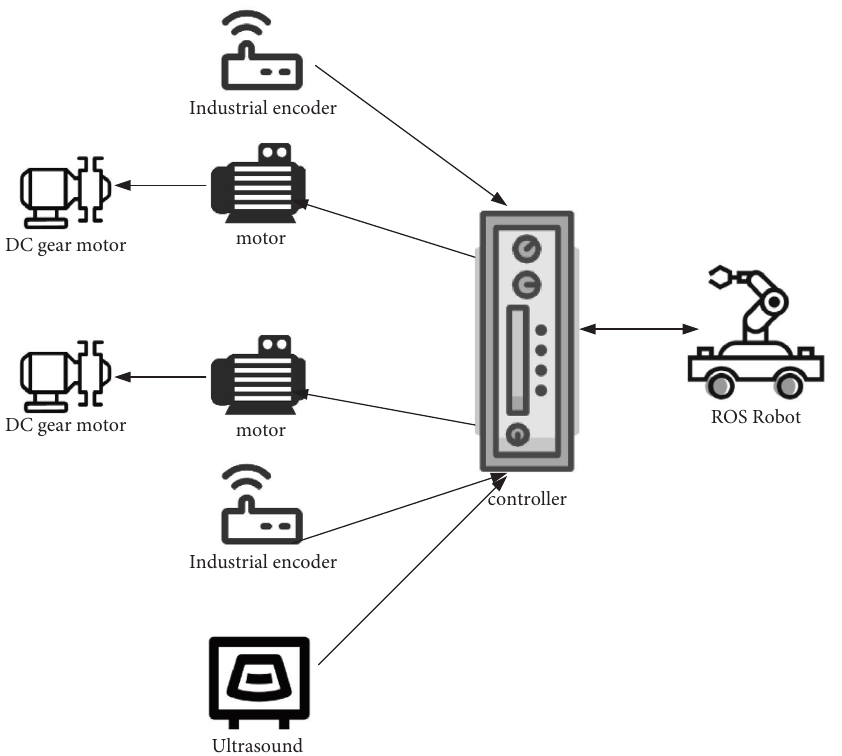
Figure 2: Te structure of the ROS robot